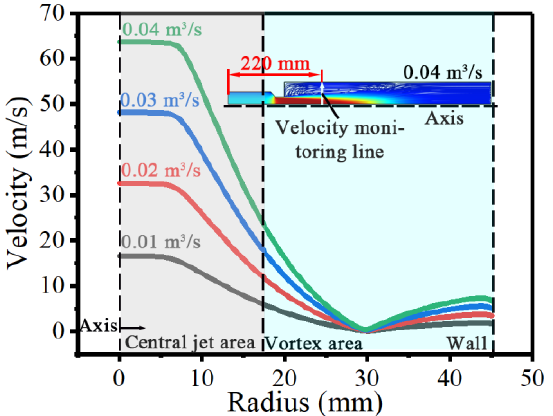
Figure 7. Velocity distributions at the monitoring line with different inlet flow rates; the fluid viscosity was set as 100 mPa·s.